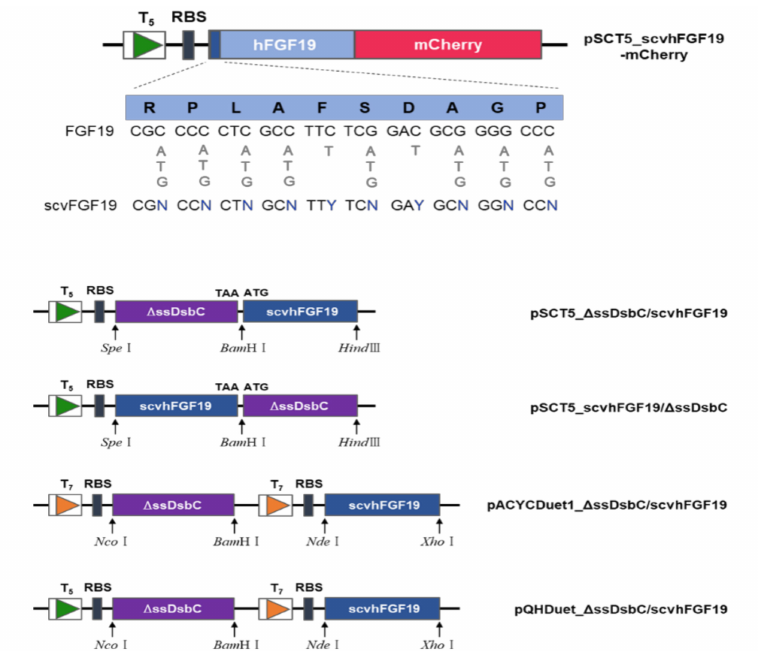
Figure 1. Schematic representation of the plasmids constructed in this study for the screening and expression of scvhFGF19. Upper panel shows a genetic map of the hFGF19-mCherry fusion protein and wobble sequences introduced into the N-terminal region of hFGF19 for codon variant library construction. Lower panel reveals schematic maps of the plasmids used for the co-expression of scvhFGF19 with ∆ ssDsbC under single, two identical, and two di ff erent